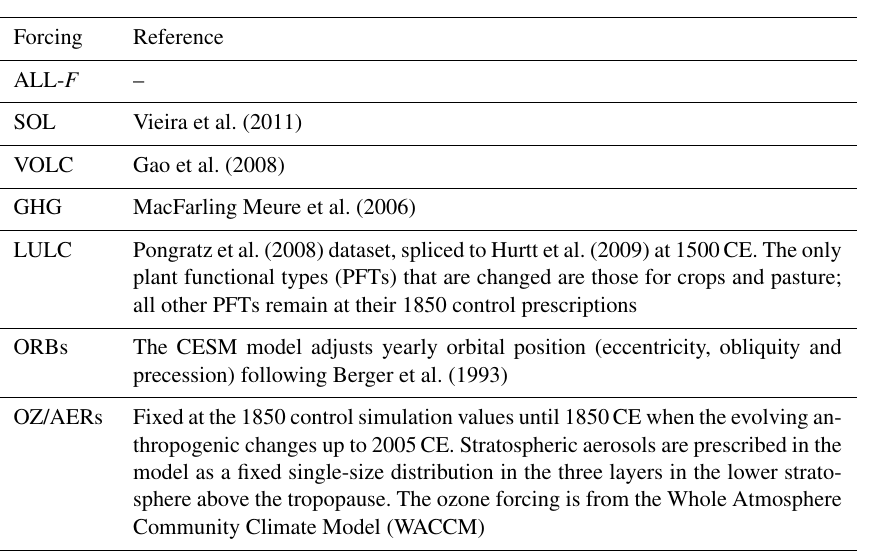
Table 2. External forcing reconstructions used in the CESM-LME, both in the ALL- F and the single- F sub-ensembles. Legend for external forcing: SOL, changes in total solar irradiance; VOLC, volcanic activity; GHG, concentrations of the well-mixed greenhouse gases CO 2 , CH 2 and N 2 O; LULC, land use land cover (changes); ORBs, orbital variations; and OZ/AERs, anthropogenic ozone and aerosols.